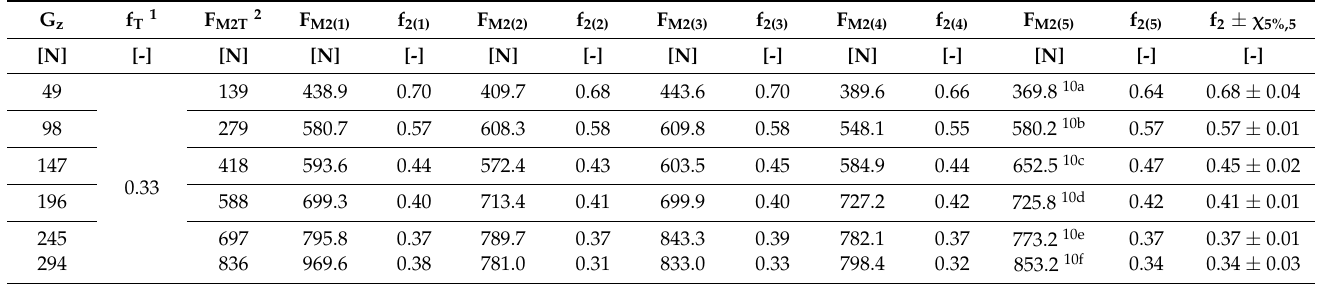
Table 10. Tensile force F M2(i) [N], φ 8 mm rope, V-shaped groove, the dihedral angle of 35 deg, contaminated with oil.